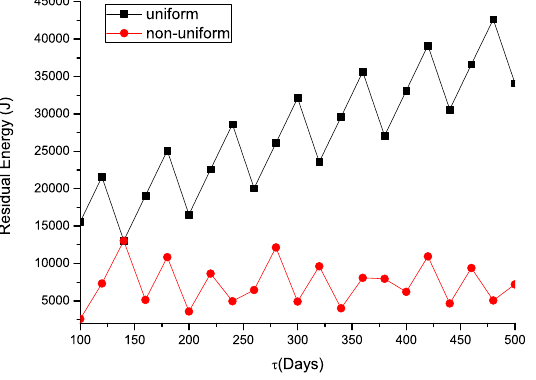
Figure 7. Residual energy in WSN under different τ ∗